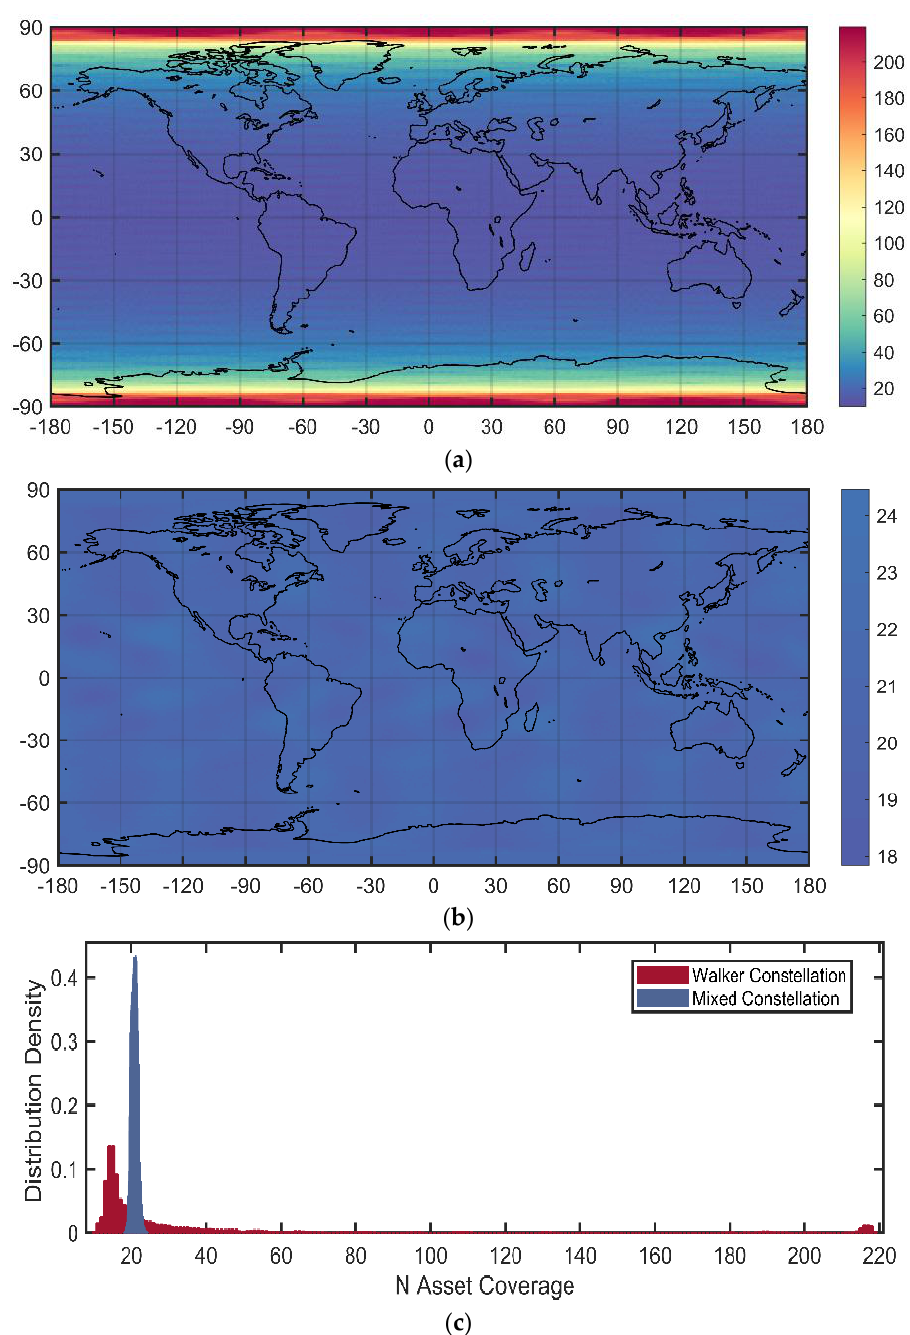
Figure 9. Global coverage performance of mixed Walker constellation vs. Walker constellation. ( a ) Distribution of N Asset Coverage around the globe for a Walker constellation with 5625 satellites; ( b ) Distribution of N Asset Coverage around the globe for a mixed Walker constellation with 5686 satellites; ( c ) Comparison of the distribution density of N Asset Coverage around the globe for the two mega-constellations.